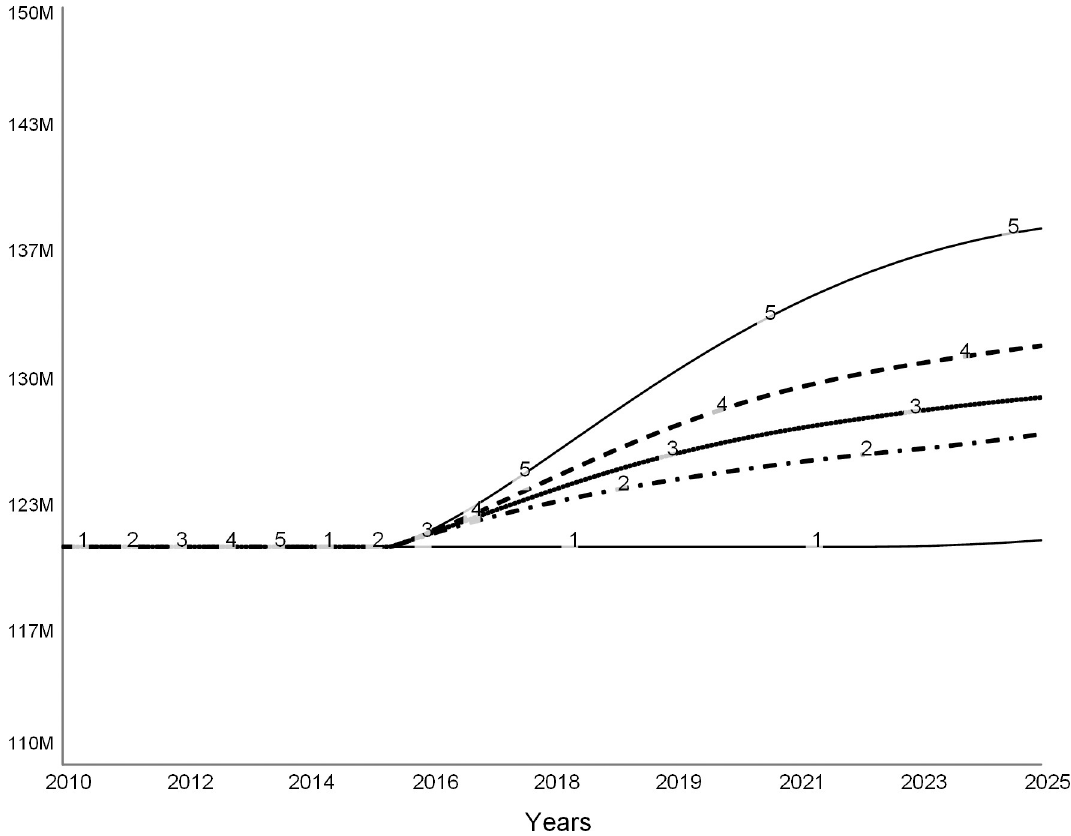
Fig 19. Expenses. Curve 1: base run. Curve 2: 0% increase in enrollments. Curve 3: 5% increase in enrollments. Curve 4: 10% increase in enrollments. Curve 5: 20% increase in enrollments.